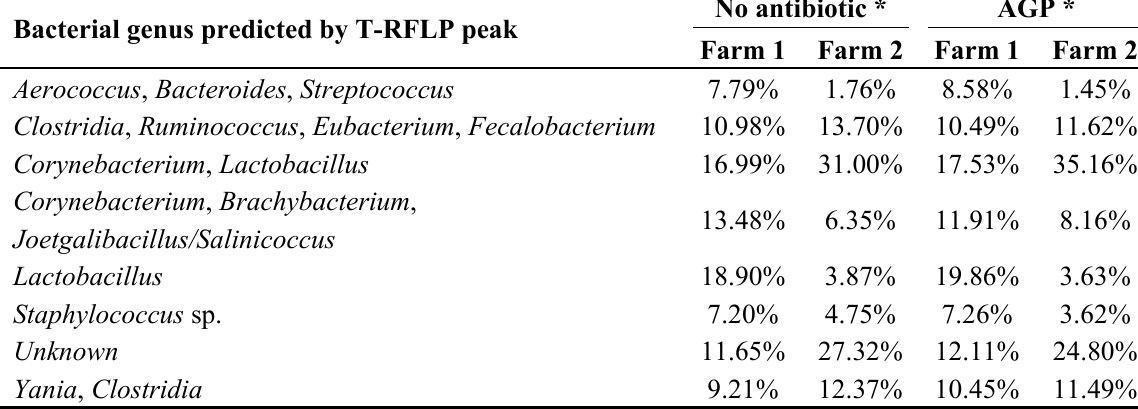
Table 4. Abundance of genera contributing greater than 2% of total 16S rRNA T-RFLP signal of litter from five sequential flocks of broiler chickens raised on commercial poultry farms. Two houses on each farm contained birds that were fed the AGP flavomycin or flavomycin + virginiamycin; two houses were fed no